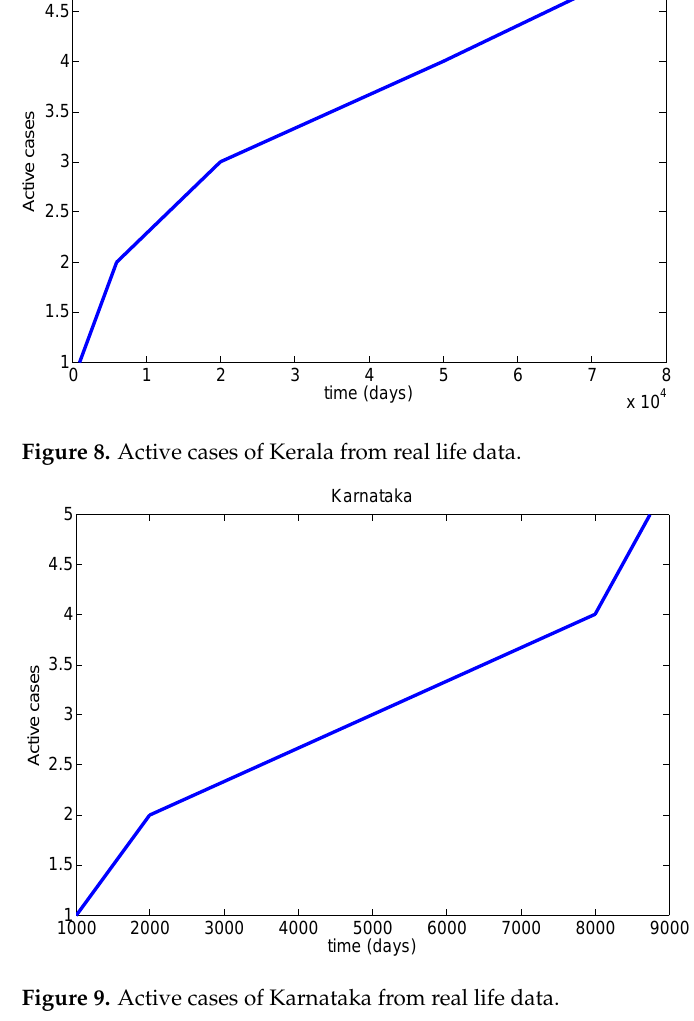
Fig. 9 Active cases of Karnataka from real life data